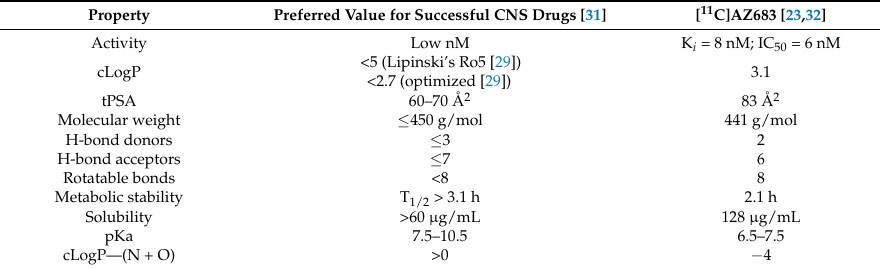
Table 1. Properties of [ 11 C]AZ683 compared to a typical CNS